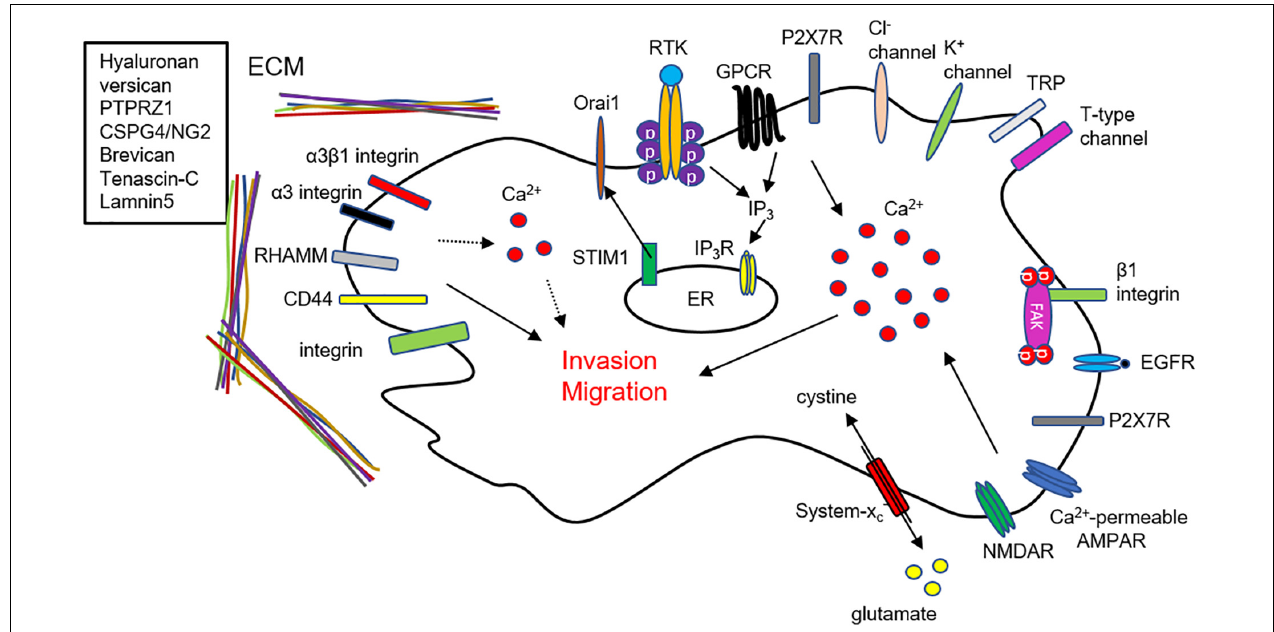
FIGURE 2 | Schematic linking mechanisms of ECM, Ca 2 + signaling, and glutamate in GBM invasion. Summary of mechanisms of glioma invasion related to ECM, Ca 2 + signaling, and glutamate. Glutamate release from GBM cells activates Ca 2 + permeable AMPARs and NMDARs in an autocrine manner, thereby cause an intracellular Ca 2 + increase in GBM cells. ECM and their binding partners affect GBM invasion by regulating Ca 2 + signaling.